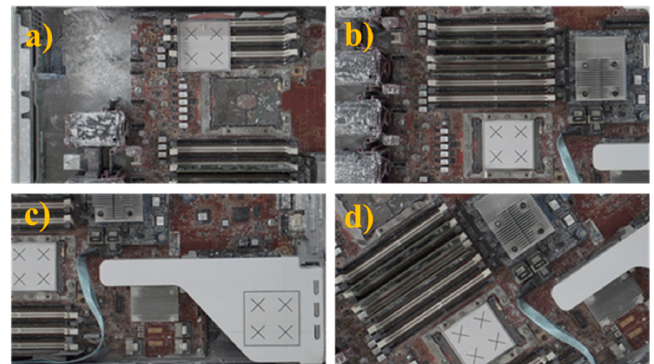
Figure 13. Four different robot poses to capture standard AOI targets images before manual displacement or rotation. Robot pose at the ( a ) 1st, ( b ) 2nd, ( c ) 3rd, and ( d ) 4th AOI target positions.